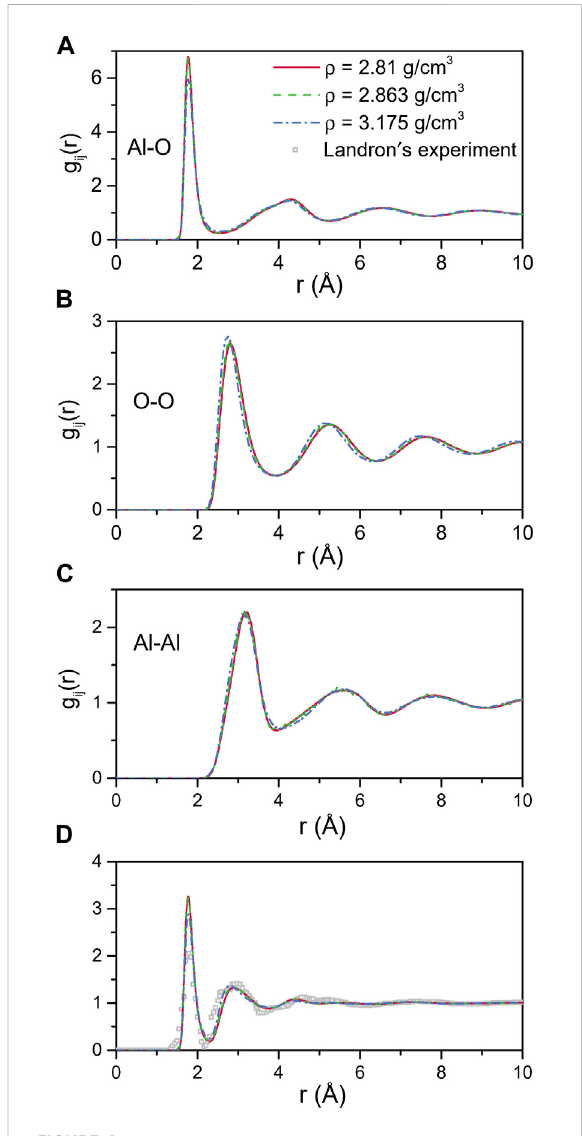
FIGURE 4 MD results for total and partial pair distribution functions for liquid alumina at 2500 K and three densities. (A) Al-O, (B) O-O and (C) Al-Alpartialpairdistributionfunctions, (D) Comparisonwiththe neutron pair distribution function from Landron ’ s